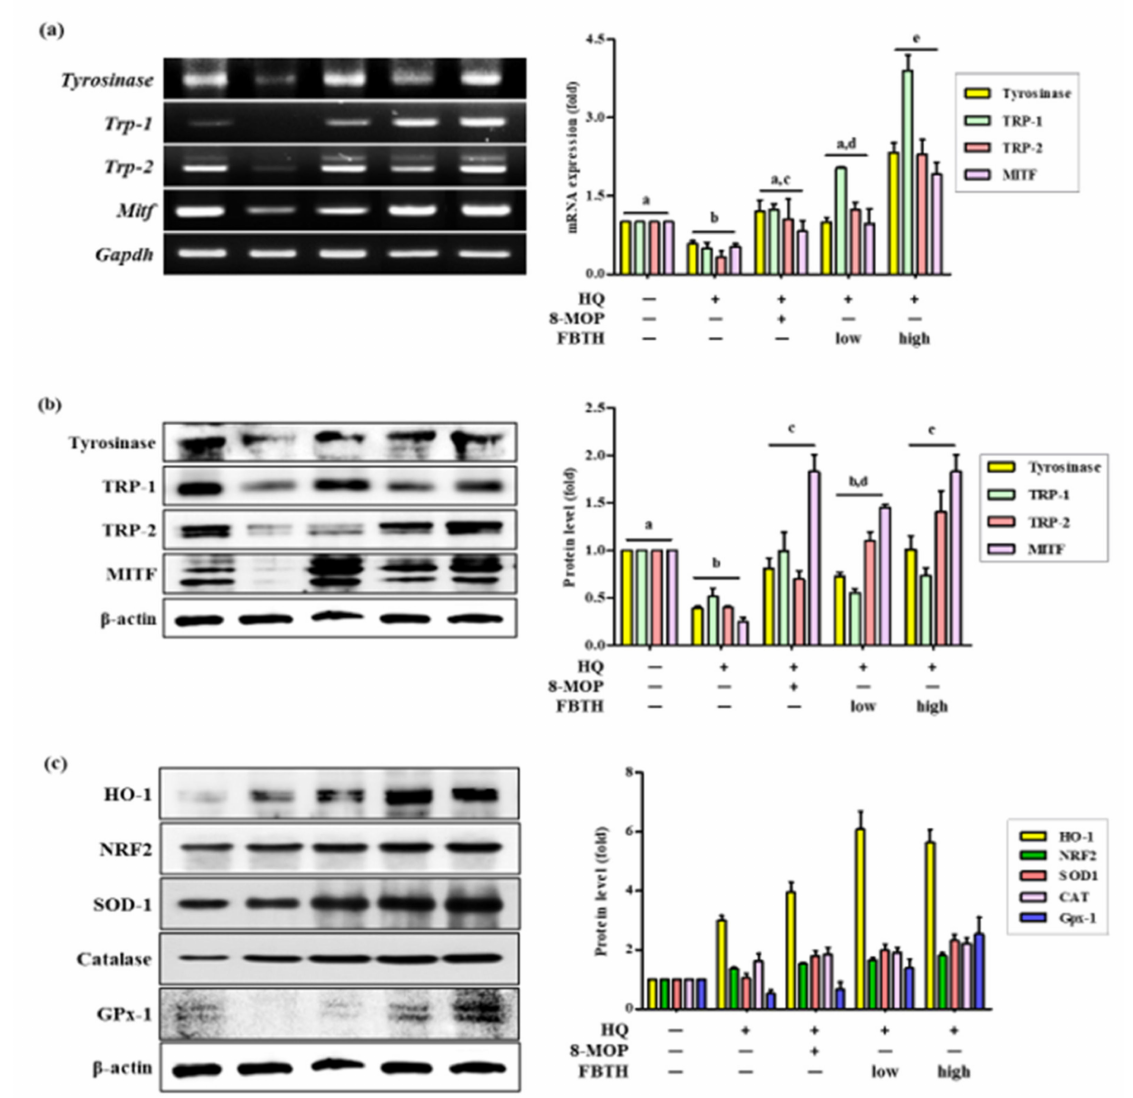
Figure 7. Comparison of mRNA and protein expression of melanogenesis and antioxidant related genes on hydroquinone-induced hair graying in C57BL/6 mice. ( a – c ) C57BL/6 mice were treated with FBTH and hydroquinone every day for two months. Then, the dorsal skin was collected, and the mRNA ( a ) or protein expressions ( b ) of melanogenesis related gene and protein expression of antioxidant related genes ( c ) were analyzed by RT-PCR and immunoblotting. Respectively. 8- MOP was used as a positive control. NT, vehicle group; HQ, hydroquinone control group; FBTH-L, low concentration (50 mg/kg/day) of the FBTH group; FBTH-H, high concentration (100 mg/kg/day) of the FBTH group. For statistical analysis, different letter indicated that they are statistically significant each